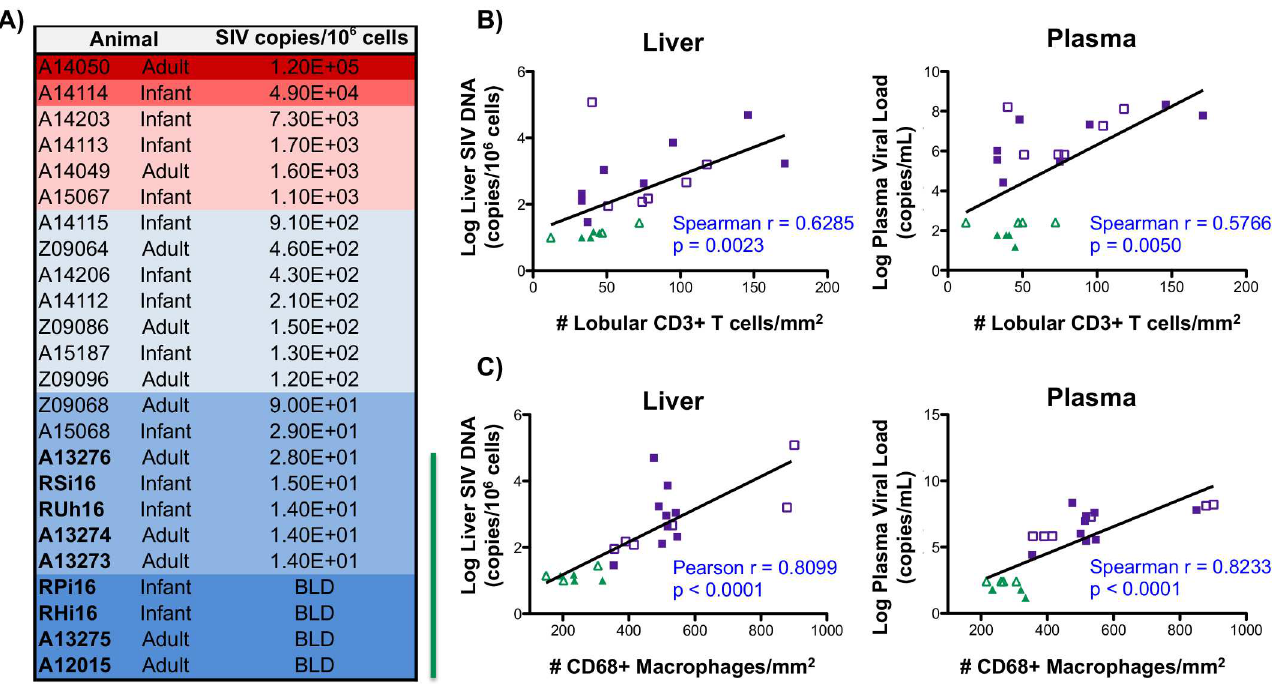
Fig 6. Liver macrophage number correlates with SIV levels. A) SIV DNA copies in samples from the livers of both infant and adult macaques were determined by quantitative hybrid real-time/digital PCR and normalized per million cell equivalents, based on parallel analysis of a single copy rhesus macaque CCR5 target template. Macaques treated with cART are denoted with bolded font and a green line to the right of the table (BLD = below the limit of detection). B-C) Correlation analysis between copies of SIV DNA in the liver (left) or plasma SIV levels (right) and liver T cell number (B) or liver macrophage number (C) in SIV-infected (purple symbols) and SIV-infected cART (green symbols) macaques. For macaques having SIV plasma viral load and SIV DNA copies below the limit of detection, the log transformed limit of detection values (30 copies/mL for plasma or 10 copies/10 6 cells for liver) were used for correlation analysis. Adult (open symbols) and infant (closed symbols) macaques are denoted.